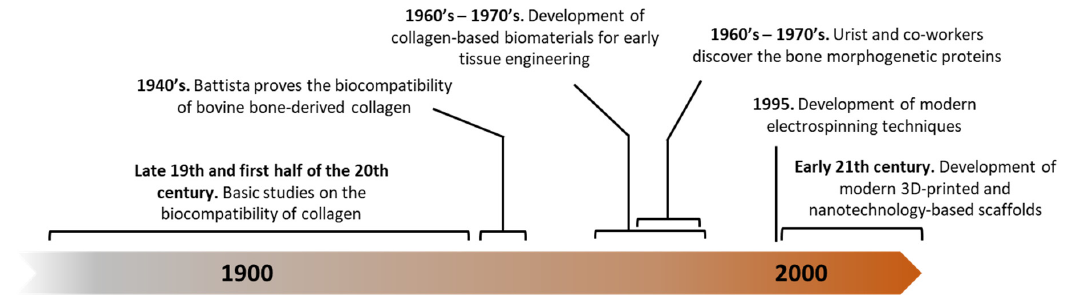
Figure 2. Timeline showing some of the major milestones in the development of collagen-based scaffolds for bone tissue engineering (BTE).